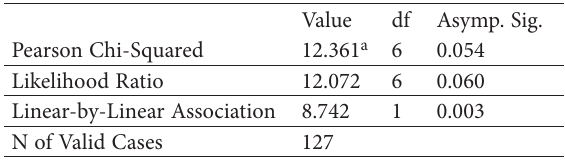
Table 6. First Officer Top 2008. Chi-Squared tests by type of Table 4. Captain Base 2008. Chi-squared tests by type of airline Value df Asymp. Sig.